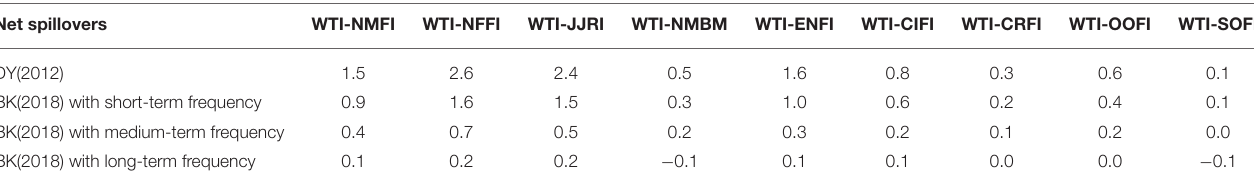
TABLE 4 | Net volatility spillover results from oil market to China’s commodity